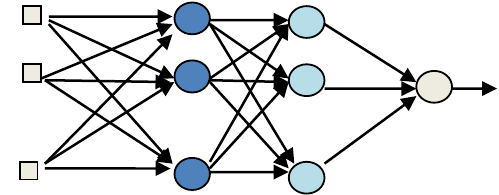
Figure 5. Neural network with two hidden layer [12].